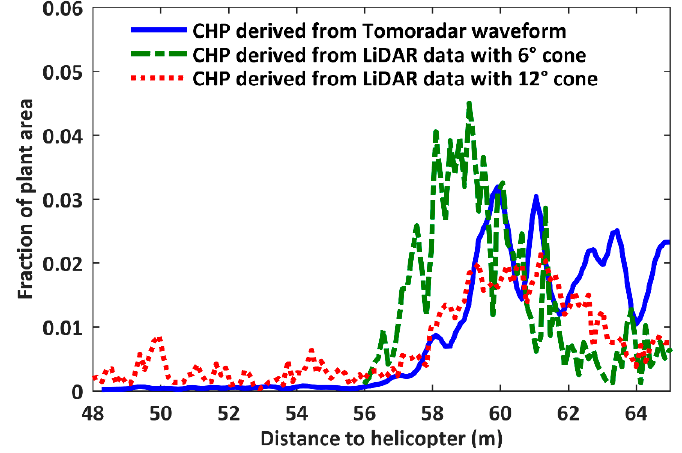
Figure 9. The CHP extracted from the 5270th Tomoradar waveform, and the LiDAR data within the Tomoradar footprint with beam width settings of six degrees and 12 degrees.